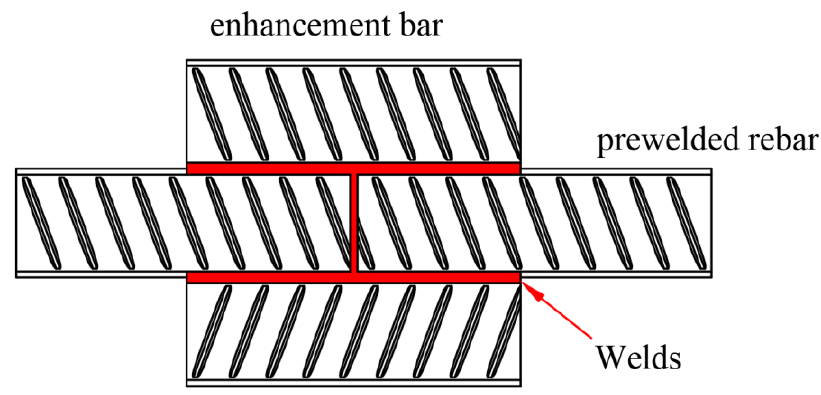
Figure 14. Schematic of the rebar bar